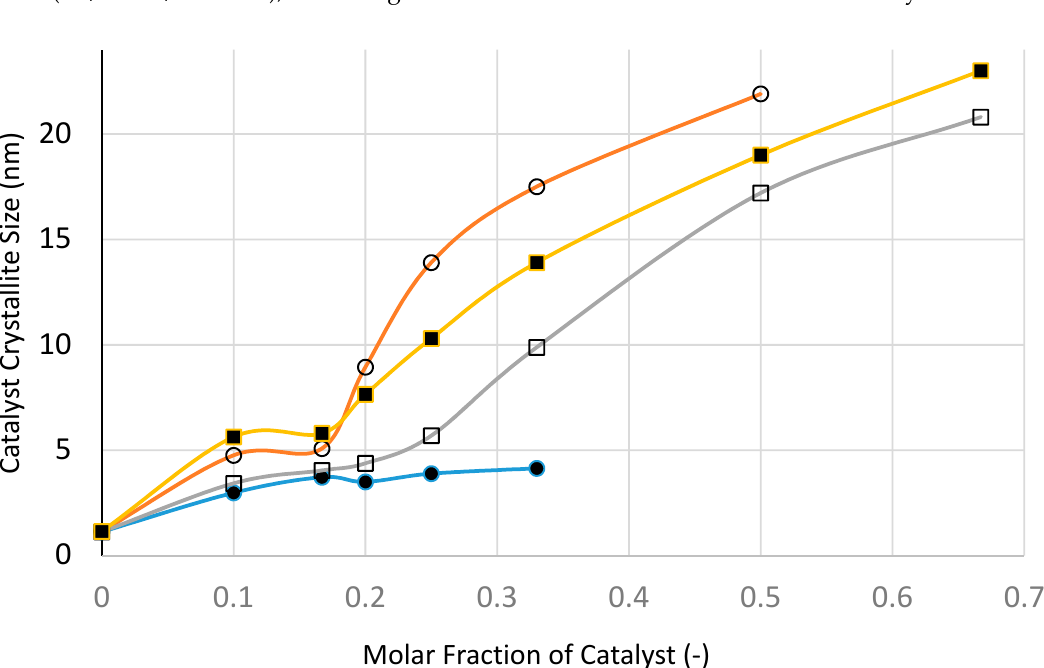
Figure 26. The effect of catalyst loading on the XRD ‐ based catalyst size of the supported nickel catalyst system before reduction with hydrogen after the formation of NiO. ( ● )—Microwave radiation at 1 kW (Stage ‐ 1a); ( ○ )—Thermal processing at 300 °C with slow heating and slow cooling using Method ‐ A, Section ‐ 3.8 (Stage ‐ 1b); ( □ )—Thermal processing at 600 °C with fast heating and fast cooling using Method ‐ B, Section 3.8 (Stage ‐ 1c); ( ■ )—Thermal processing at 600 °C with slow heating and slow